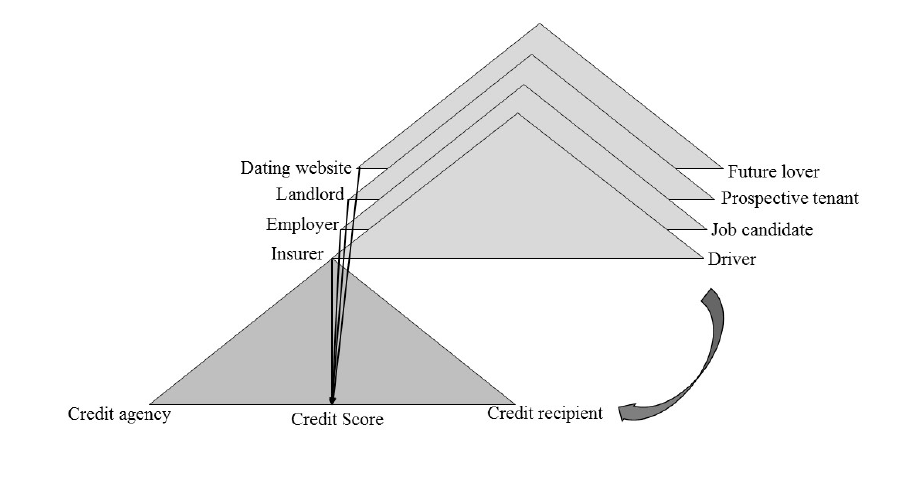
Figure 3 Travelling judgments Source: Authors’ depiction based on Fourcade and Healy (2013, 2017); Rona-Tas